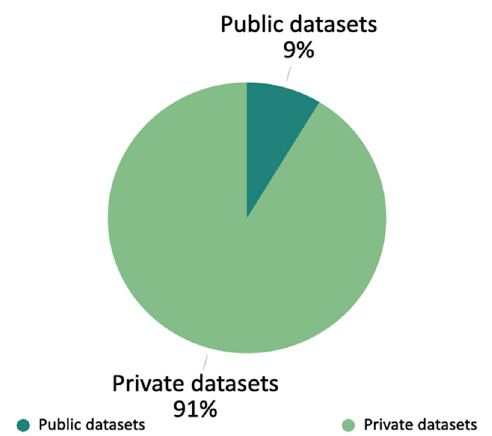
Figure 6. The ratio of the number of the papers using datasets: a comparison of public datasets to private datasets.